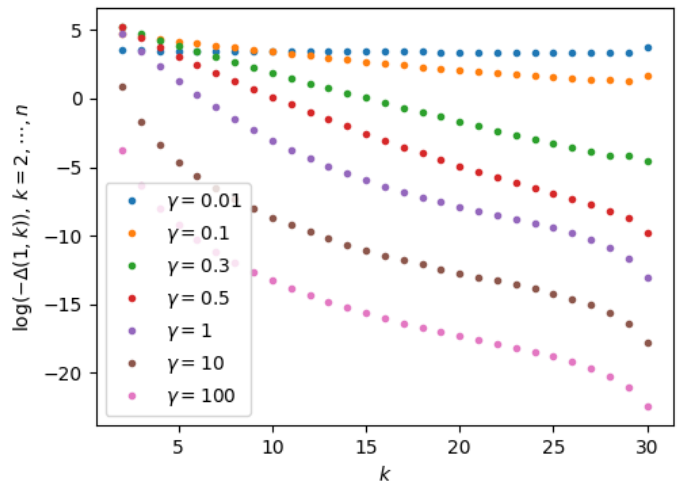
Figure 2: Plot of − ∆ in log scale for a chain of n = 30 oscillators, for different 1, k values of γ . In the overdamping limit first neighbours are strongly favoured, while in the underdamped limit spatial proximity in the bulk does not play a role, and only the endpoint oscillators are slightly